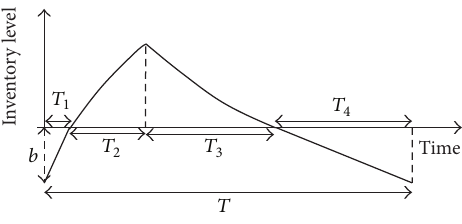
Figure 1: The inventory level of the